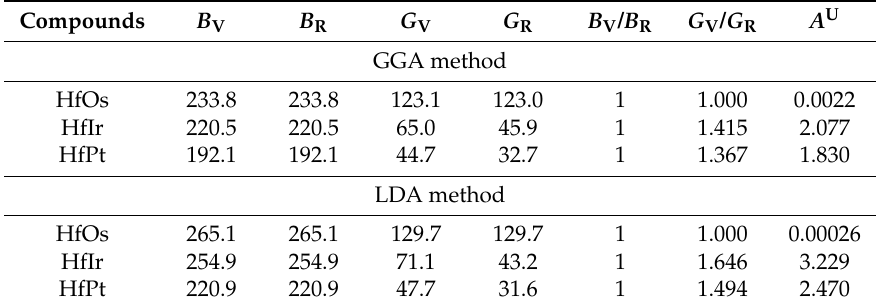
Table 4. The calculated Voigt and Reuss bounds for bulk (shear) modulus, and universal anisotropic index ( A U ) for HfX (X = Os, Ir and Pt).